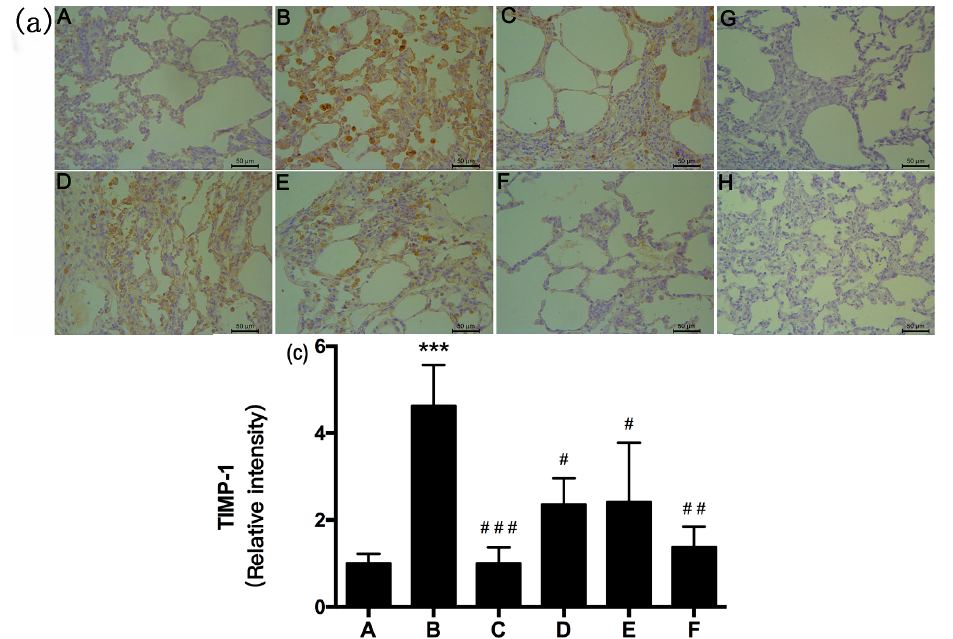
Figure 7. Effects of RRL on the levels of tissue inhibitors of metalloproteinase-1 (TIMP-1) in the lung tissues after bleomycin (BLM)-induced in rats. ( a ) representative immunohistochemistry image (Bar = 50 μ m). ( A ) normal group; ( B ) model group; ( C ) PAG group; ( D – F ) are RRL groups treated with 125, 250 and 500 mg/kg, respectively; ( G ) negative control of omitted first antibody; ( H ) negative control of omitted second antibody; ( b ) the quantitative analysis of TIMP-1 protein in lung tissues. Data represent the mean ± standard deviation (SD) ( n = 3) (*** p < 0.001 vs. normal group, # p < 0.05, ## p < 0.01, ### p < 0.001 vs. model group).